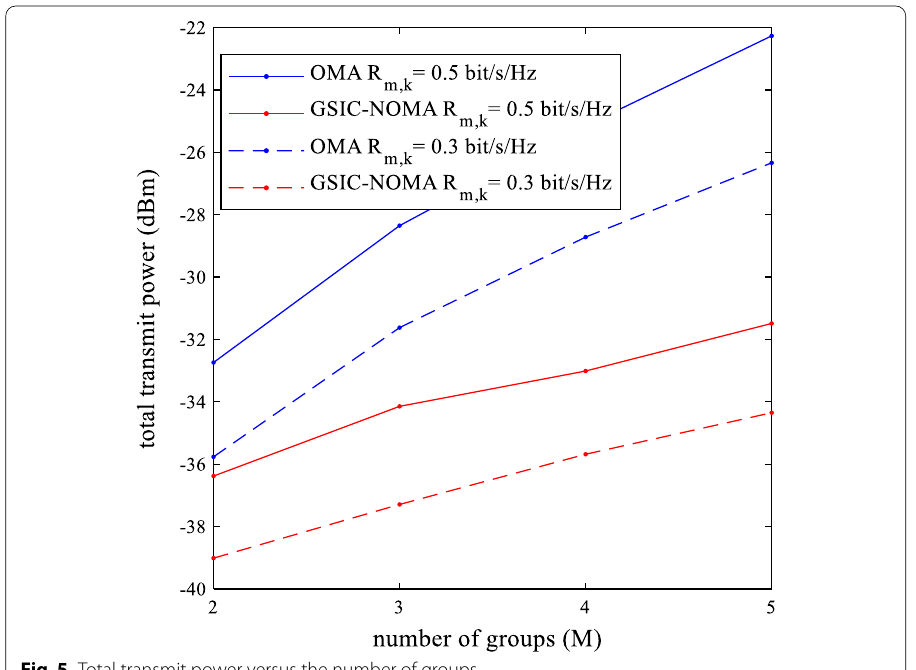
Fig. 5 Total transmit power versus the number of